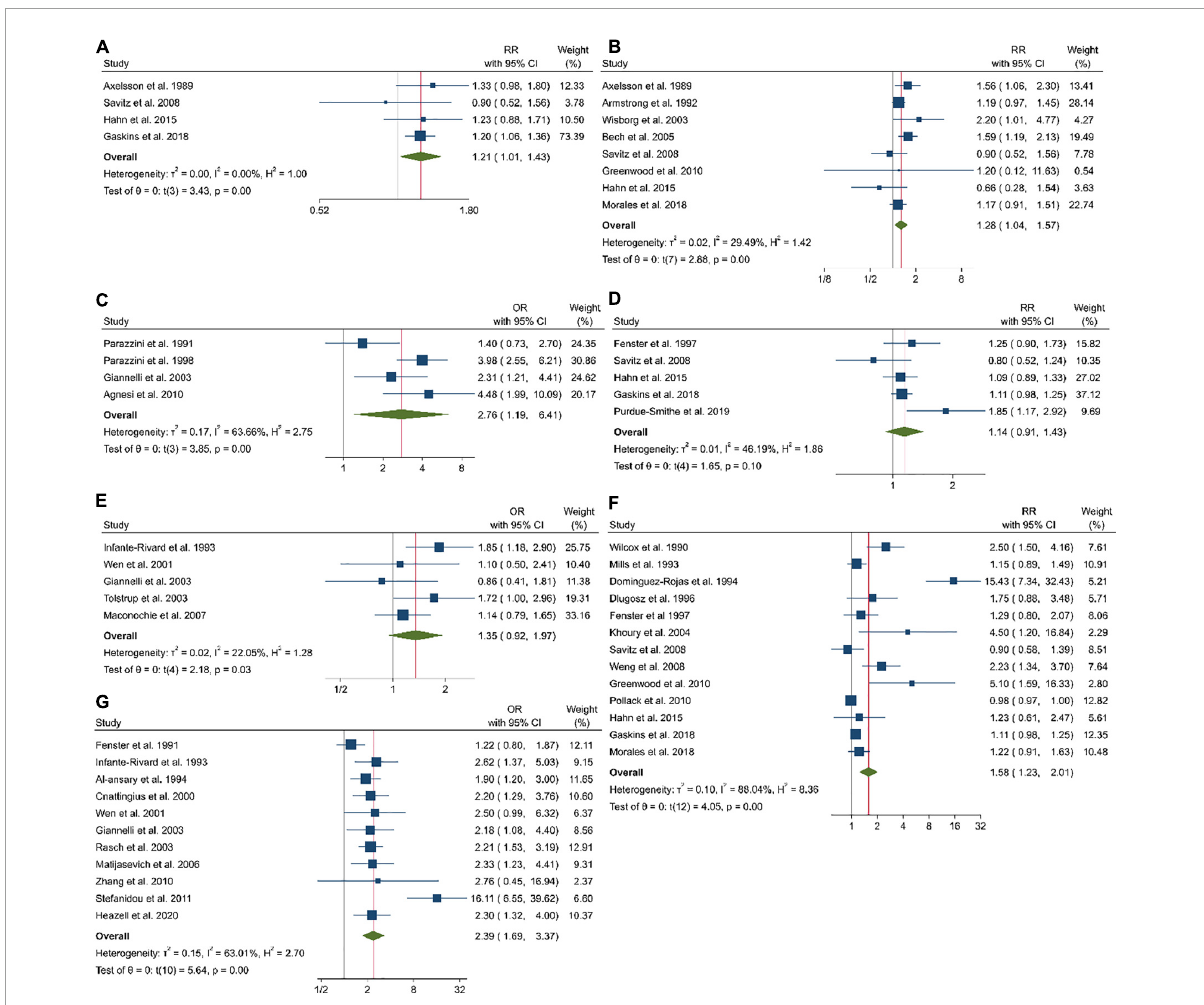
FIGURE2 Forest plots of the estimated relative risk (RR) of pregnancy loss related to coffee intake before pregnancy in cohort studies (A) , coffee intake during pregnancy in cohort studies (B) , coffee intake during pregnancy in case-control studies (C) , caffeine intake before pregnancy in cohort studies (D) , caffeine intake before pregnancy in case-control studies (E) , caffeine intake during pregnancy in cohort studies (F) , and caffeine intake during pregnancy in case-control studies (G) .